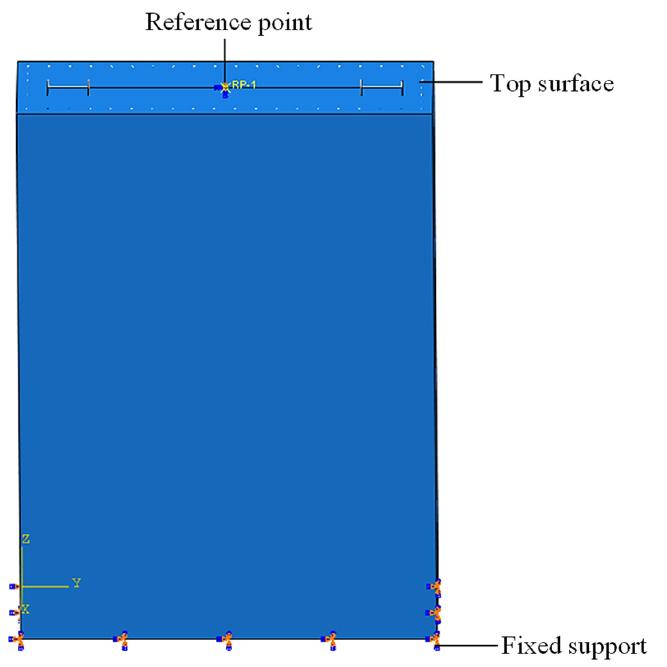
Figure 3. Boundary Figure 3. Boundary conditions.